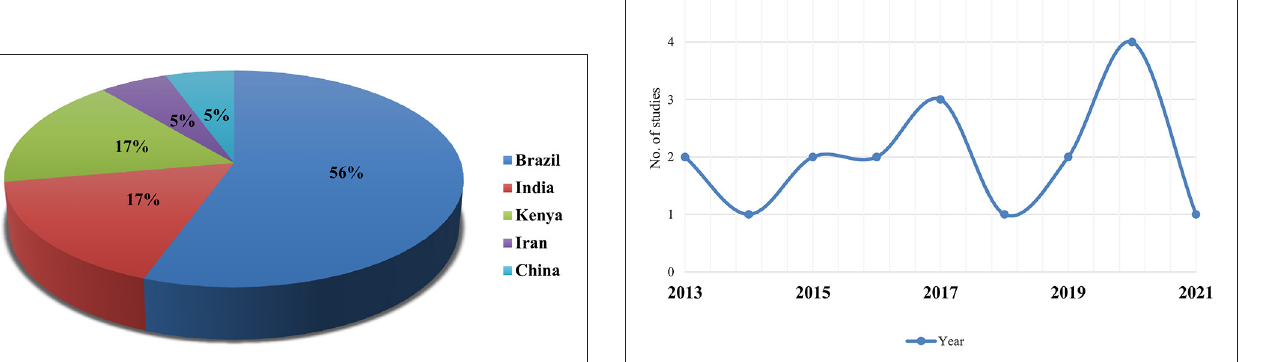
Frontiers in Veterinary Science |